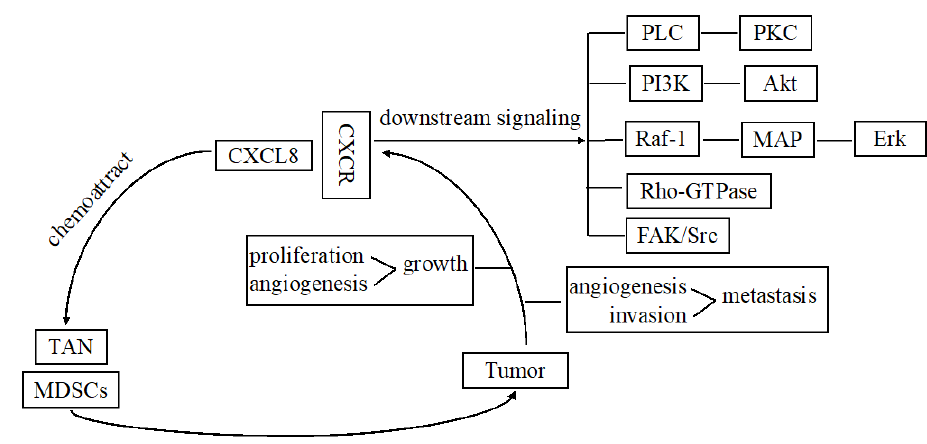
Figure 1. Diagram summarizing the major signaling pathways of CXCL8 in cancers.